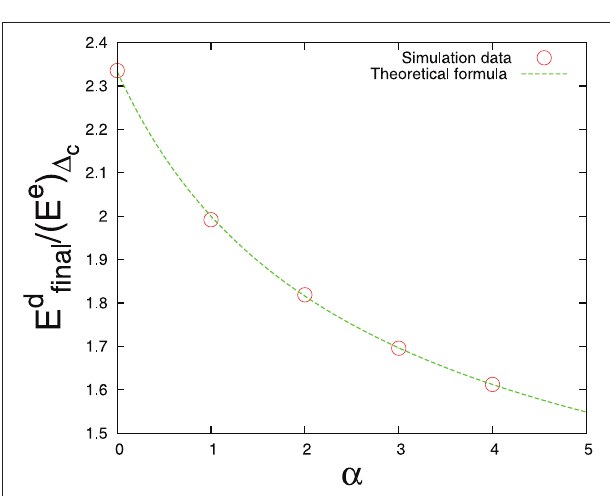
FIGURE 3 | Ratio between damage energy of final catastrophic avalanche and damage energy at the failure point 1 c vs. power law exponent α . Single bundle with N 10 7 fibers. Solid line is the theoretical estimate (Equation 25). =